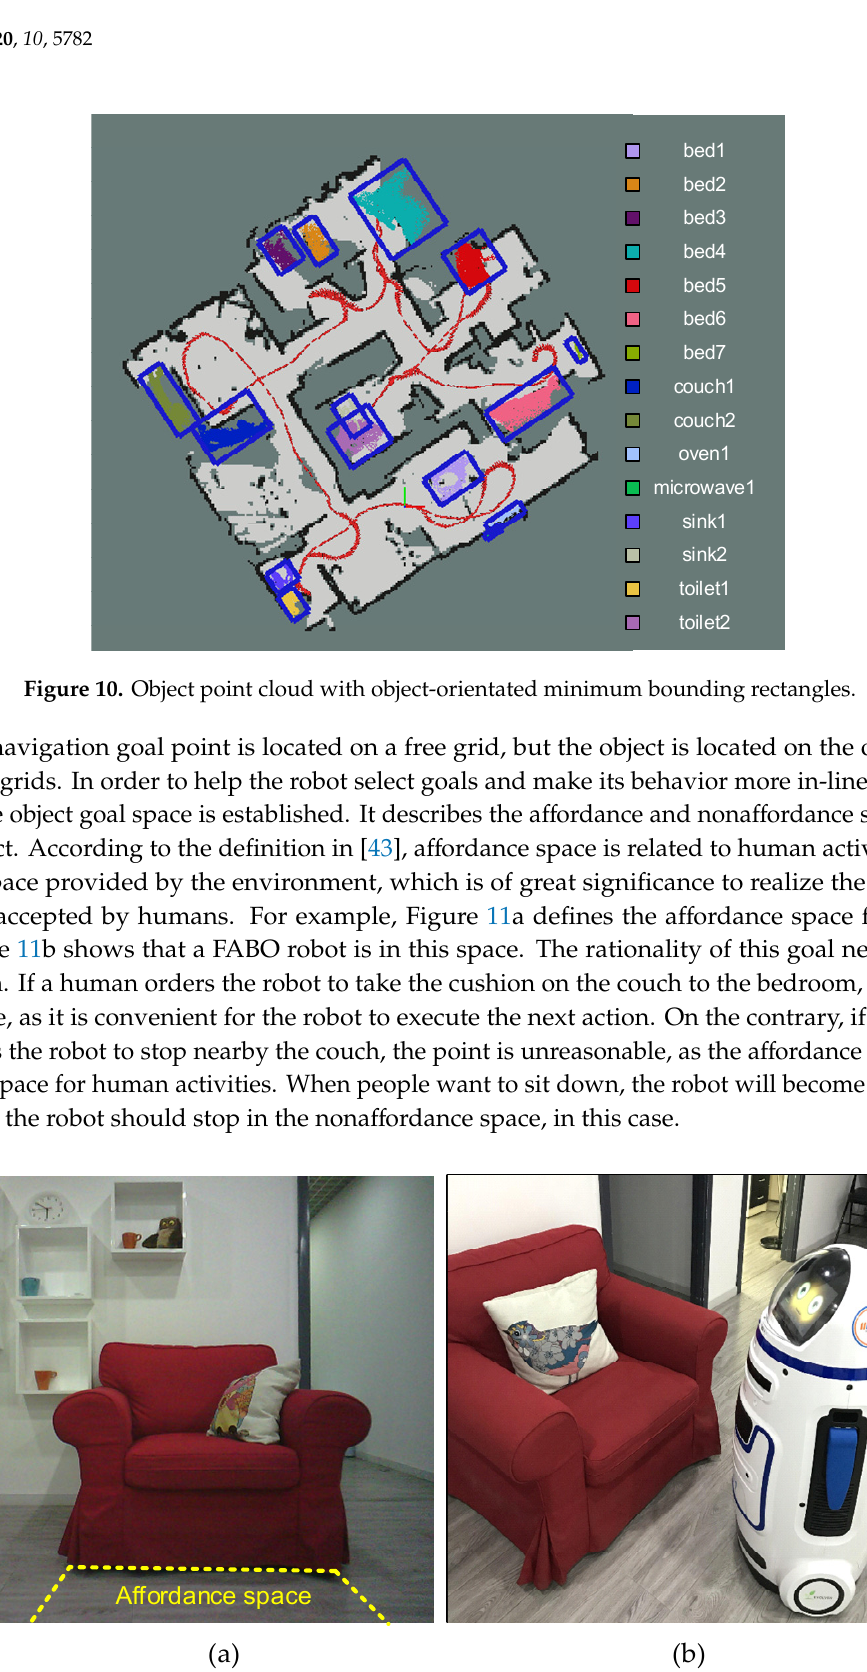
Figure 11. Affordance space: ( a ) the affordance space of a couch, and ( b ) a FABO robot parked in the space.